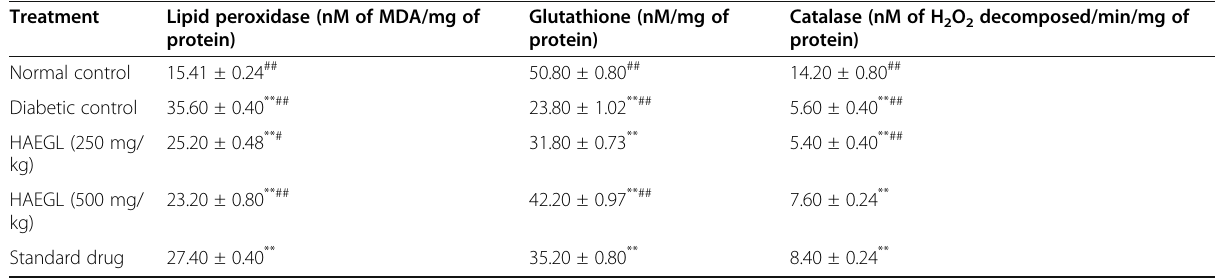
Table 7 Effect of HAEGL on liver in vivo antioxidant enzymes in streptozotocin-induced diabetic rats on the 15th day of treatment Treatment Lipid peroxidase (nM of MDA/mg of